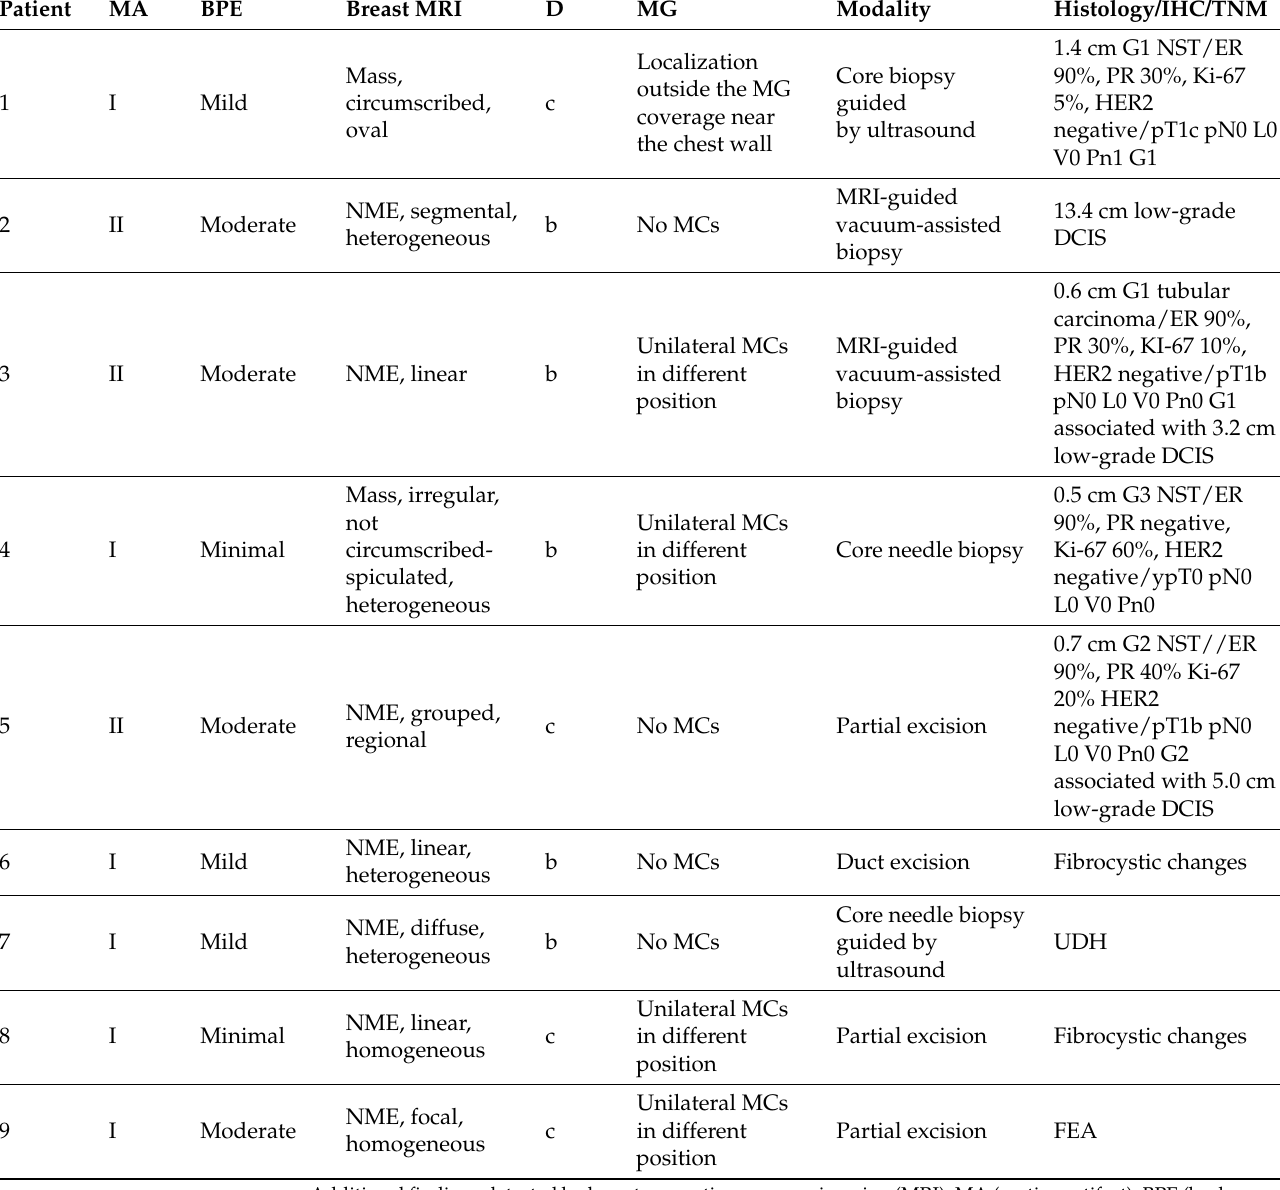
Table 2. Additional findings detected by breast magnetic resonance imaging